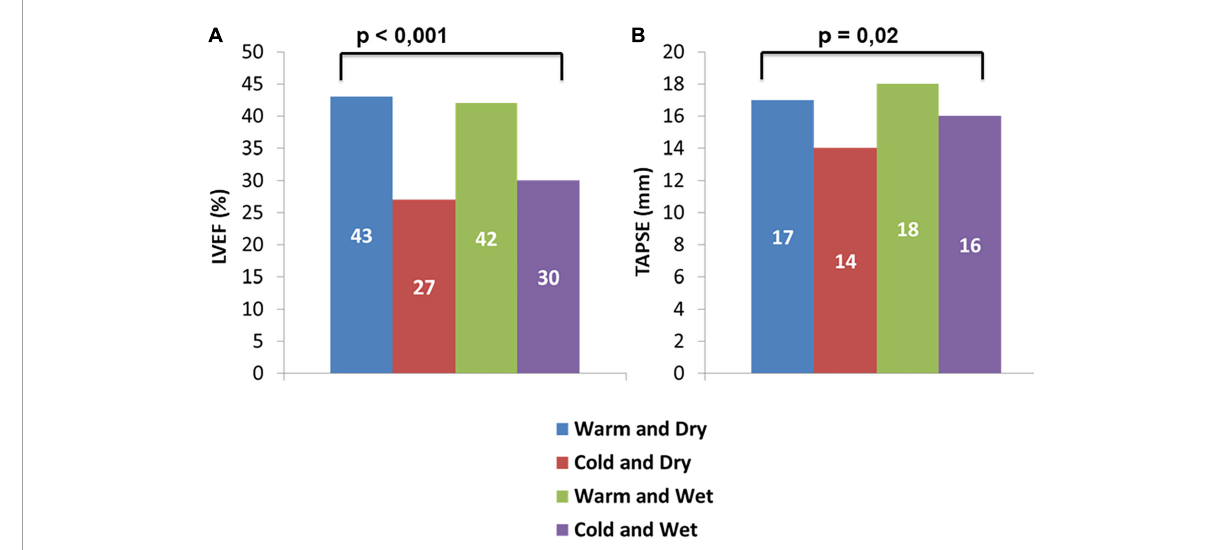
FIGURE2 Difference in median of LVEF (A) and TAPSE (B) among AHF patients’